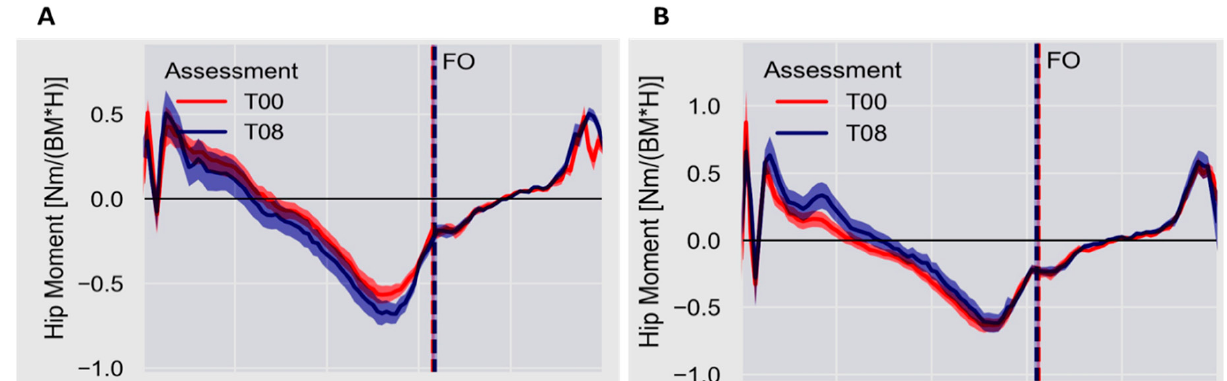
Figure 2. ( A ) Mean time series of the hip flexor moment during gait of the intervention group at baseline (T00) and 8 weeks (T08). ( B ) Mean time series of the hip flexor moment during gait of the control group at baseline (T00) and 8 weeks (T08). The dotted lines correspond to end of the propulsion phase/beginning of the swing phase of gait.